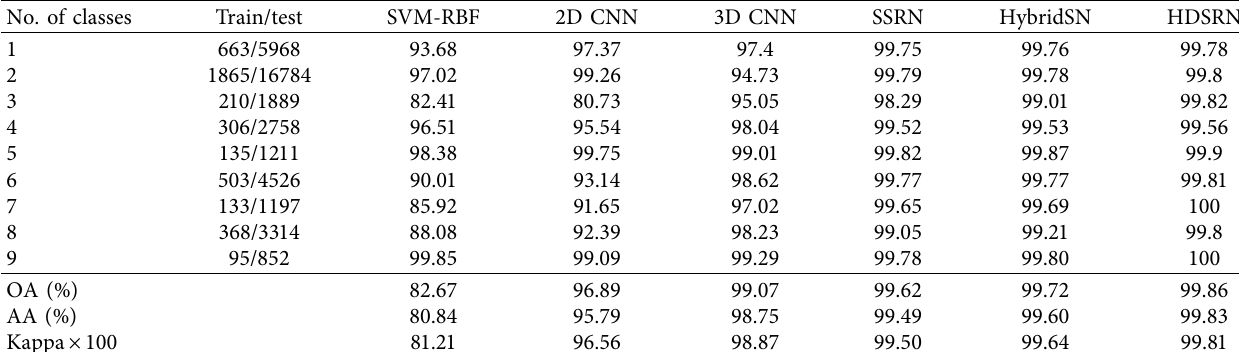
Table 9: The comparison of experiments in the UP